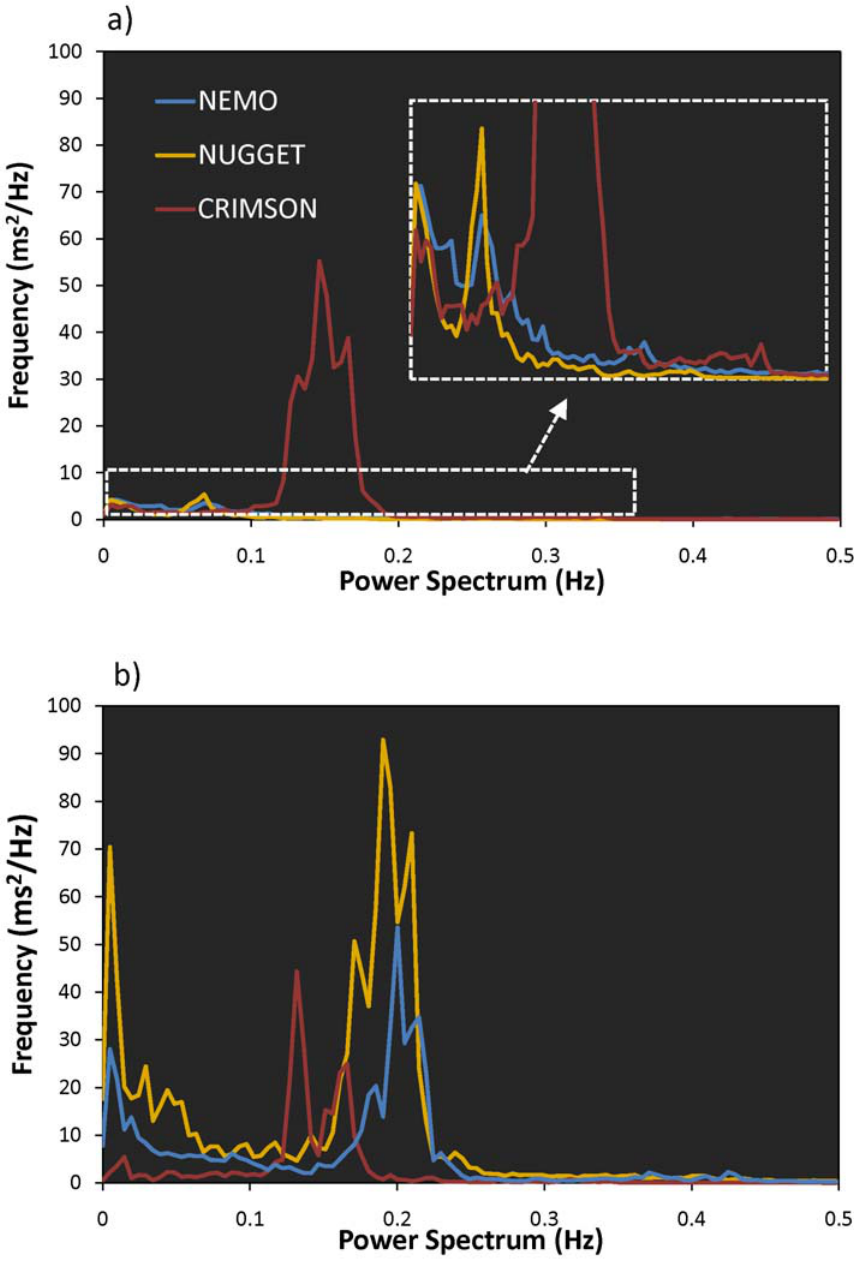
Figure 5. Averaged spectral analysis of the heart rate variability over the periods of inactivity of the two koalas in contact with tourists (Nugget and Crimson) and the koala without human contact (Nemo) during a) the day (1:00–6:00 PM) with an enlarged portion highlighting the small LF peaks; and b) the evening (6:00–10:00 PM).